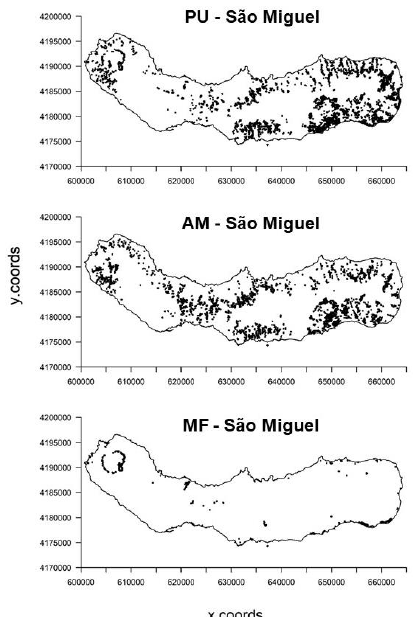
Figure 3. Species distribution data for P. undulatum (PU), A. melanoxylon (AM), and M. faya (MF) in São Miguel Island.